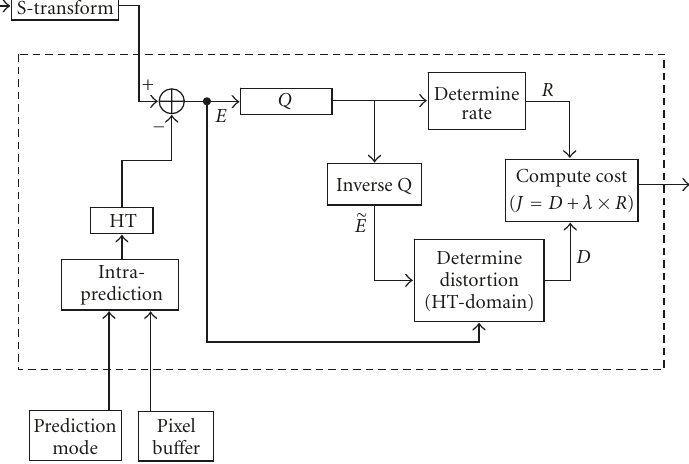
Figure 7: Transform-domain RD cost